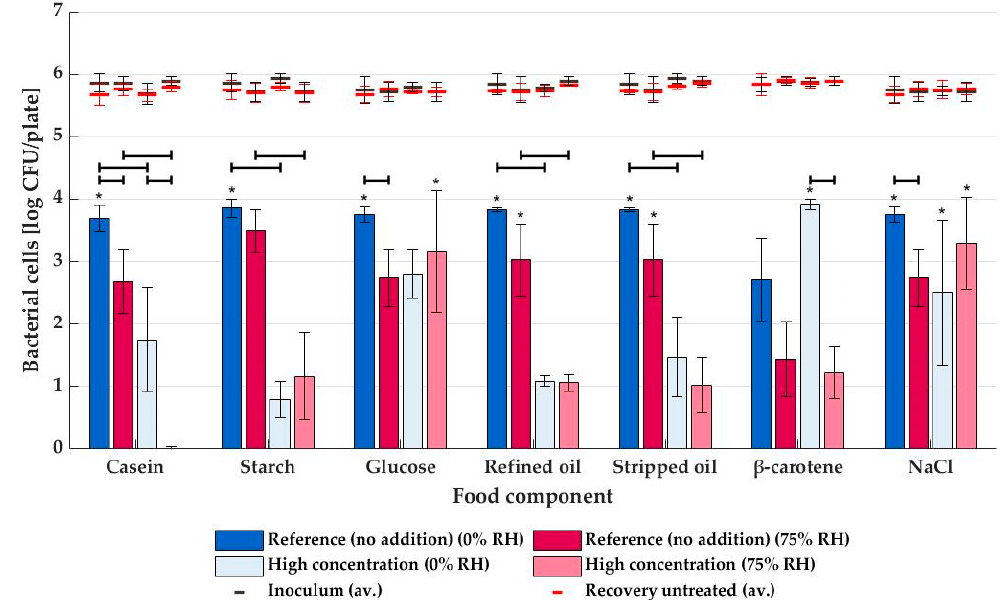
Figure 4. Average NTP inactivation levels (and standard deviations) of STEC on agar media supplemented with various food matrix components ( n = 3), with plasma generated from dry air (0% RH, blue bars) and humid air (75% RH, red bars). An asterisk (*) indicates that inactivation reached LOD for at least one repeat. All components were tested at high concentrations (see Table 1) and compared against a reference sample without addition. The average inoculum and number of cells recovered from untreated samples are given as black and red lines, respectively. Significant differences between inactivation levels are indicated with black horizontal lines.